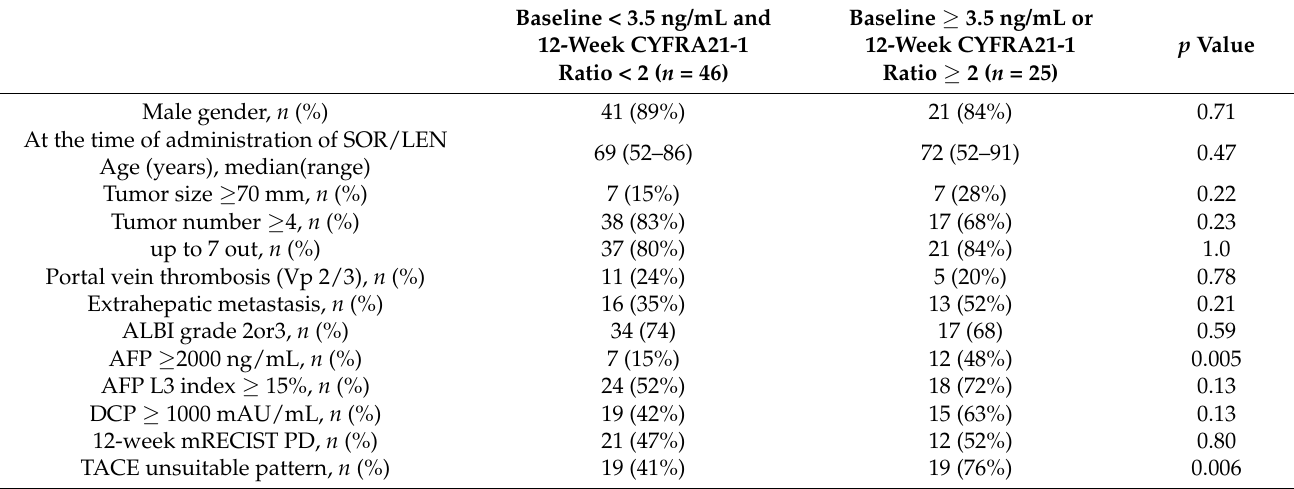
Table 3. Patient characteristics according to serum CYFRA21-1